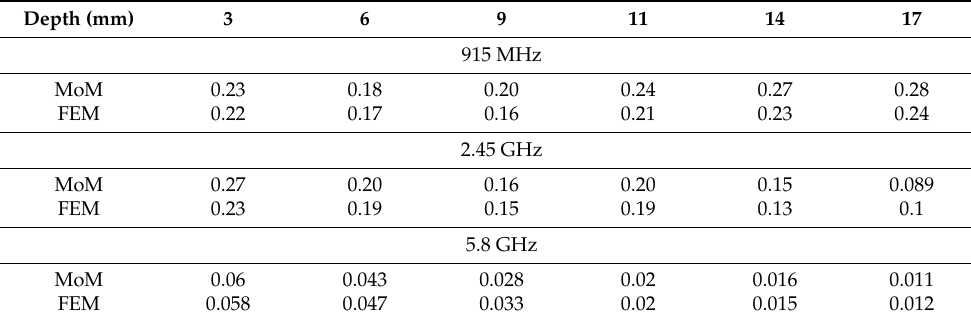
Table 2. Comparison between two methods at different